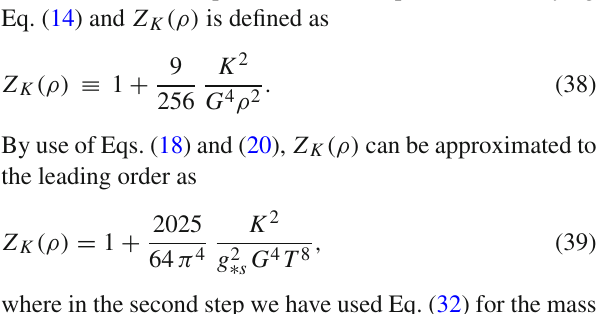
Fig. 1 Plotofbaryonasymmetryparameterversusthe(rescaled)Kani- adakis